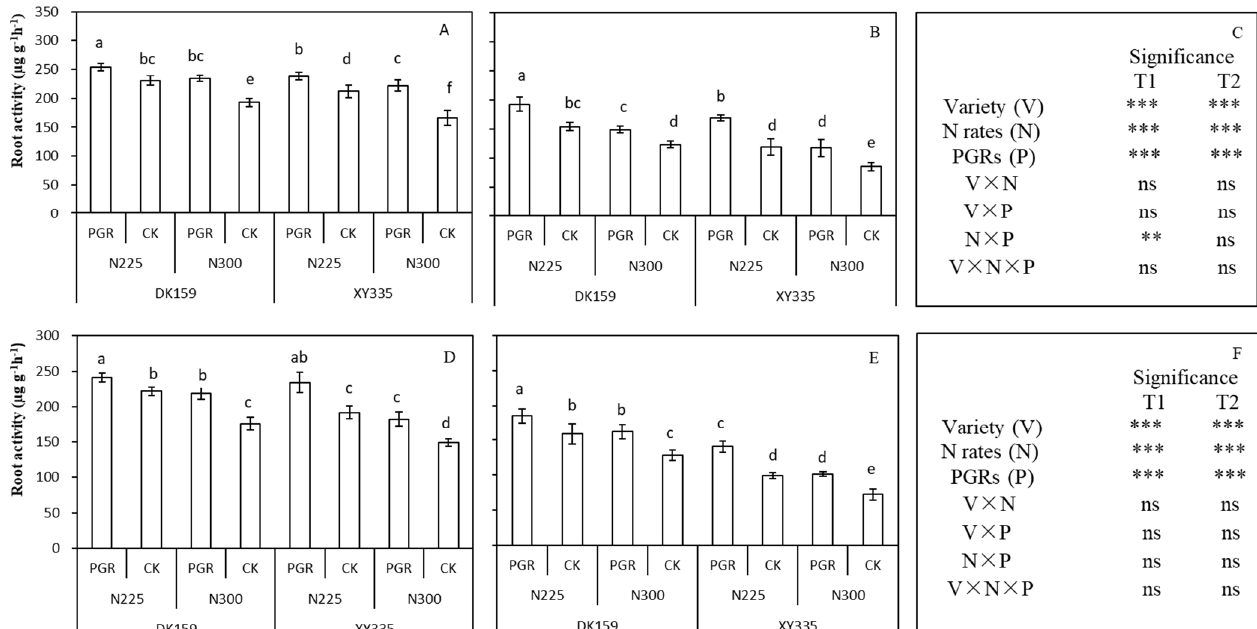
Figure 2. Effects of PGRs and nitrogen fertilizer on the root TTC reducing activity at 10 days after silking ( A , D ) and 30 days after silking ( B , E ) in 2019 and 2020. Effects of Variety (V), N rates (N), PGRs (P), and their interaction effects in 2019 ( C ) and 2020 ( F ) were listed (T1 represents 10 days after silking; T2 represents 30 days after silking). The vertical bars denote the mean ± the standard error of the mean; ns means non-significant; ** and *** indicate significance at p < 0.01 and < 0.001 probability levels, respectively. Different lowercase letters represent significant differences among treatments ( p <